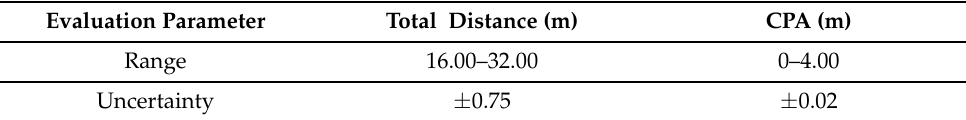
Table 5. Range of values for construction of Case Study I and II MFs.